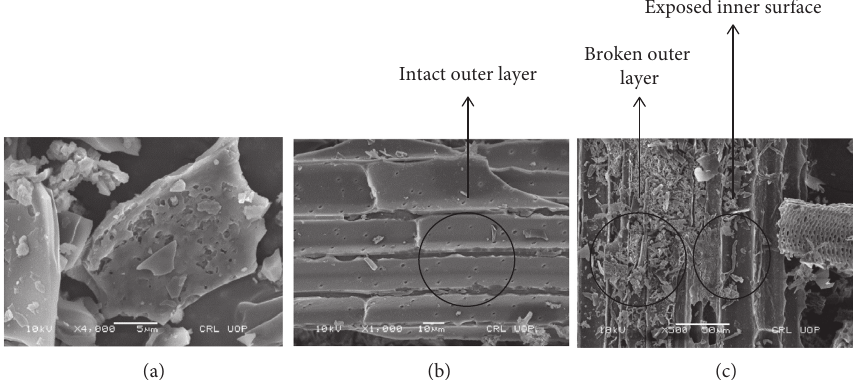
Figure 11: (a) Smooth surface at 800 ° C. (b) CS400 showing outer layer. (c) CS500 (outer layers blot out). Table 4: Physical and chemical properties of CSA incinerated at 500 °